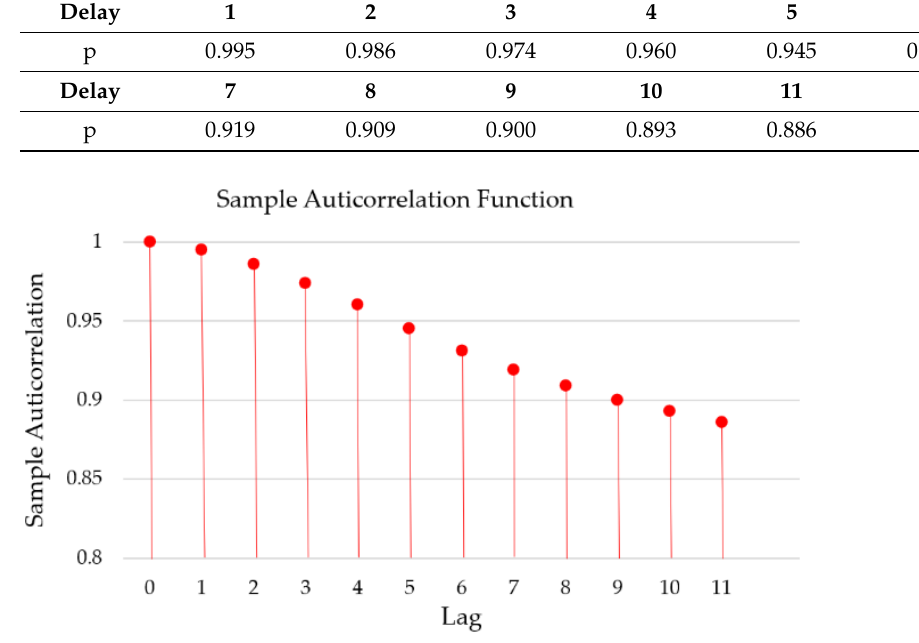
Figure 2. Autocorrelation function diagram.